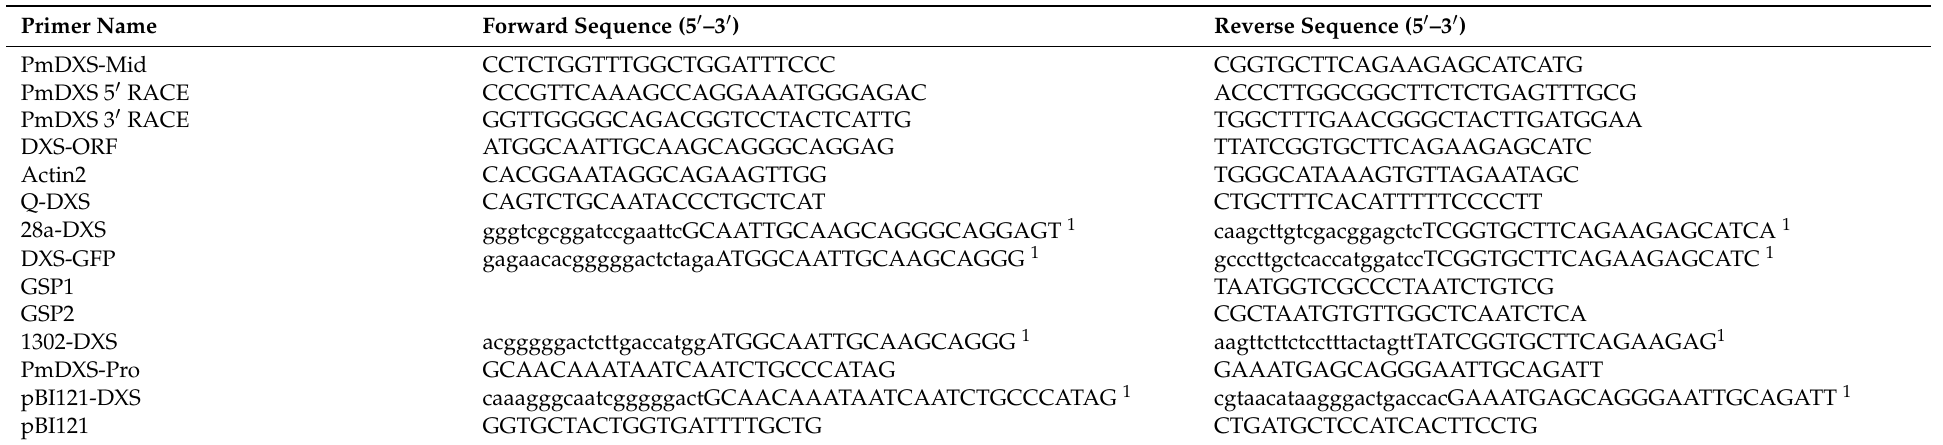
Table 1. The sequences of primers used in this